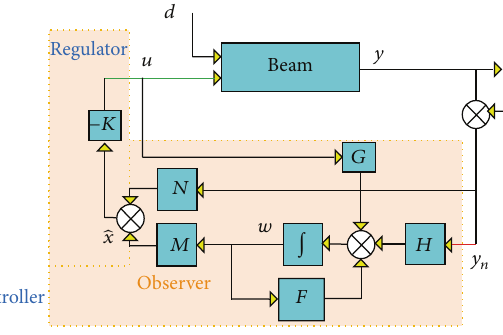
Figure 2: LQR controller with state